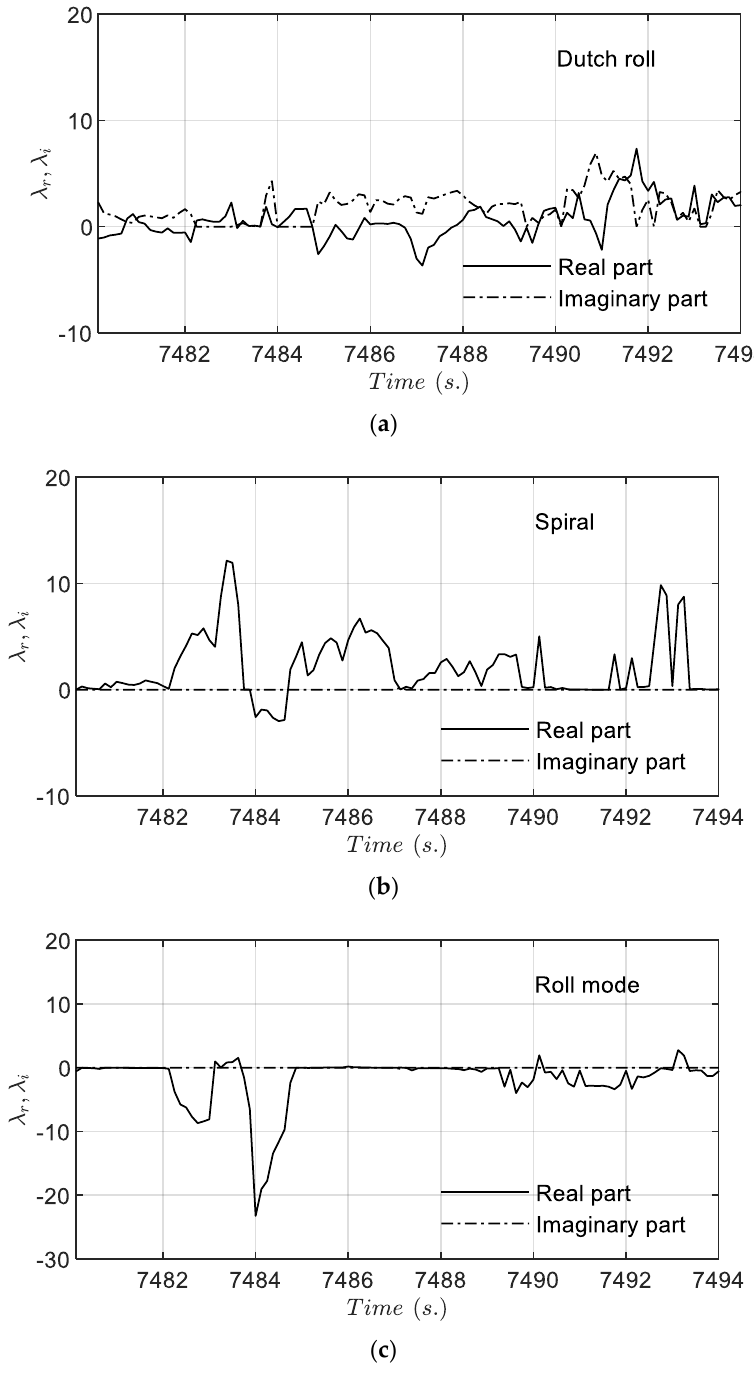
Figure 9. Eigenvalues of lateral-directional modes of motion. ( a ) Eigenvalues of the Dutch roll mode; ( b ) Eigenvalues of the spiral mode; ( c ) Eigenvalues of the roll mode. Airlines care about the vertical plunging mode of motion, which is not considered in classical flight dynamics. According to [28], in vertical plunging motion, the damping C . It may be possible to define the severity of plunging motion term is mainly related to z based on the vertical plunging equation of motion. For the present purpose, if the severity is defined by the lowest load factor developed, this transport aircraft developed −1 .05 g with h = 57.3 m (around t = 7483 s). The phugoid